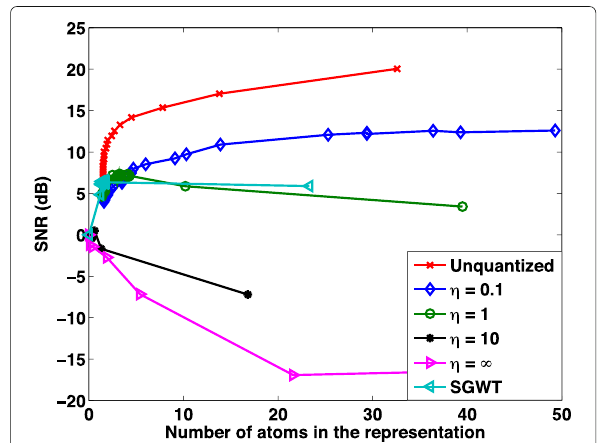
Fig. 5 Distributed approximation performance (SNR) versus sparsity level, achieved with different polynomial graph dictionary learned with different values of η in distributed settings, with a bit rate of 6 bits per